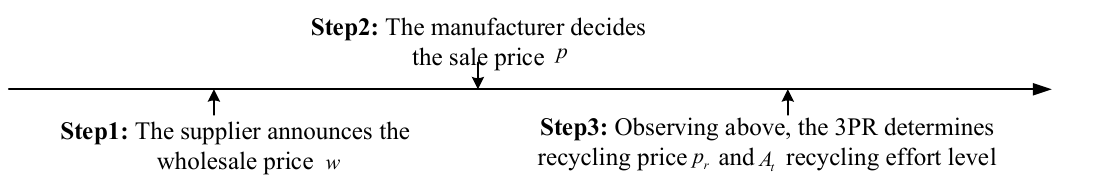
Figure 2. The flow diagram of this game sequence in the CLSC with cost-sharing contract.